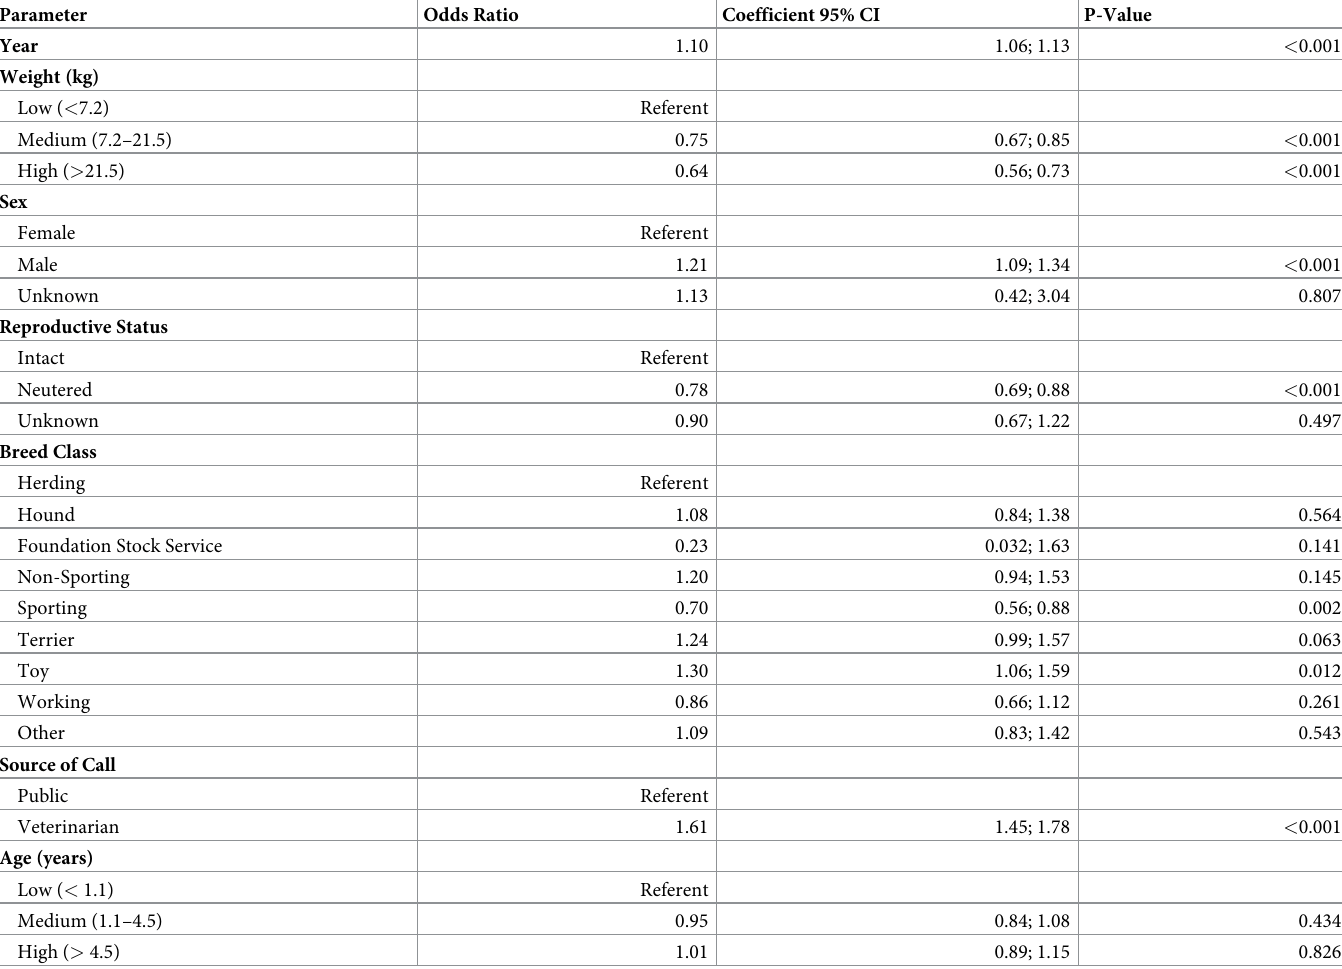
Table 5. Results of univariable mixed logistic regression models † examining associations between each individual dog-level variable on the odds of a US dog-associ- ated poisoning call to the APCC a being related to cannabis